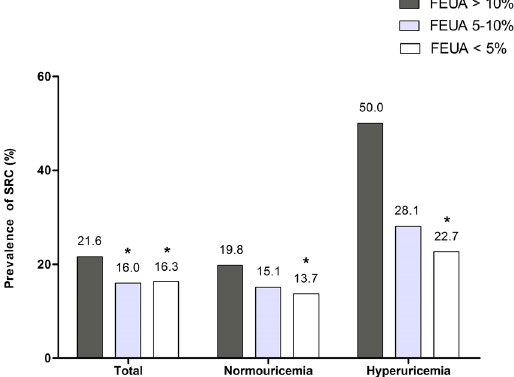
Figure 2. Simple renal cysts (SRC) prevalence among different fractional excretions of uric acid (FEUAs) groups in the total population, and in hyperuricemic and normouricemic subjects. The subjects were divided into three groups (FEUA > 10%, 5–10%, and < 5%). * P < 0.05 compared with the FEUA > 10% group.